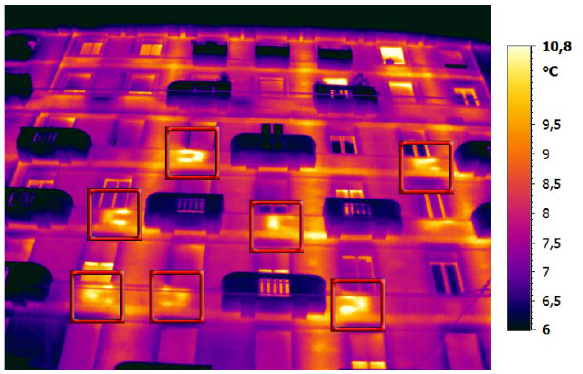
Figure 8 - Detail of the temperature distribution on the upper part of the façade (Case Study 2), above the main entrance. In the red squares, the warmer areas due to the heat flux generated by the heaters. The reduced thickness of the masonry where the heaters are located causes higher surface temperatures, especially at the connections between the heater and the hot water